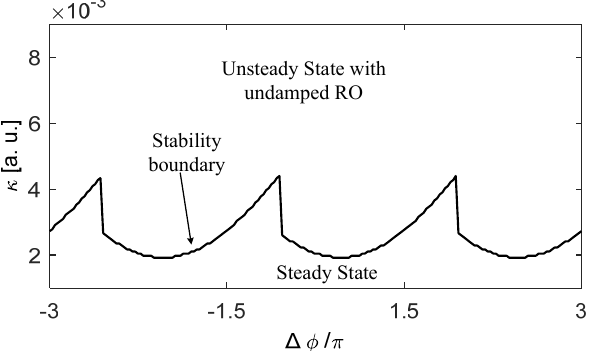
Figure 11. SMI system stability boundary with the change of optical phase when J = 1.3 J th, L = 16 cm.